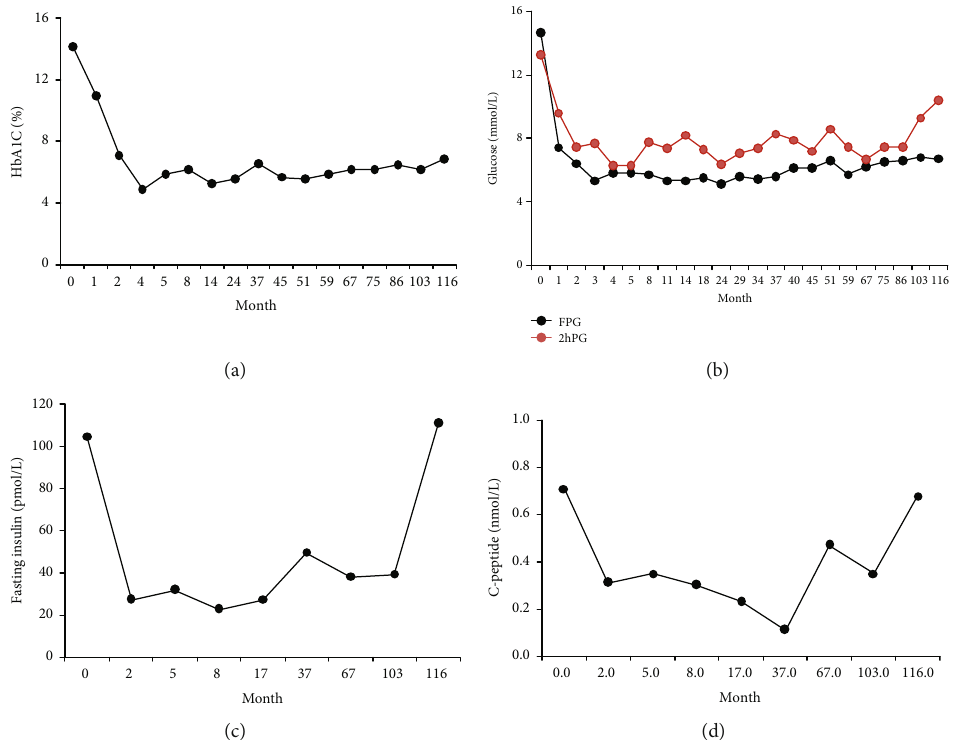
Figure 1: Intervention of TCM decreased blood glucose and improved islet function. (a) Changes in HbA1c: the level of HbA1c decreased signi fi cantly after the initial 3 months of treatment and showed a downward trend that tended to be stable after the long-term treatment. (b) Changes in glucose: the level of FPG and 2hPG showed a downward trend and fl uctuated within the control standard range. (c) Changes in fasting insulin: the level of fasting insulin improved after the long-term treatment. (d) Changes in C-peptide: the level of C- peptide improved after the long-term treatment. TCM: traditional Chinese medicine; HbA1c: glycosylated hemoglobin; FPG: fasting plasma glucose; 2hPG: 2-hour postprandial blood ( Radix Paeoniae Rubra ) 540 g, Shanzhuyu ( Fructus Macro- carpii ) 540 g, Tianhuafen ( Radix Trichosanthis ) 540 g,